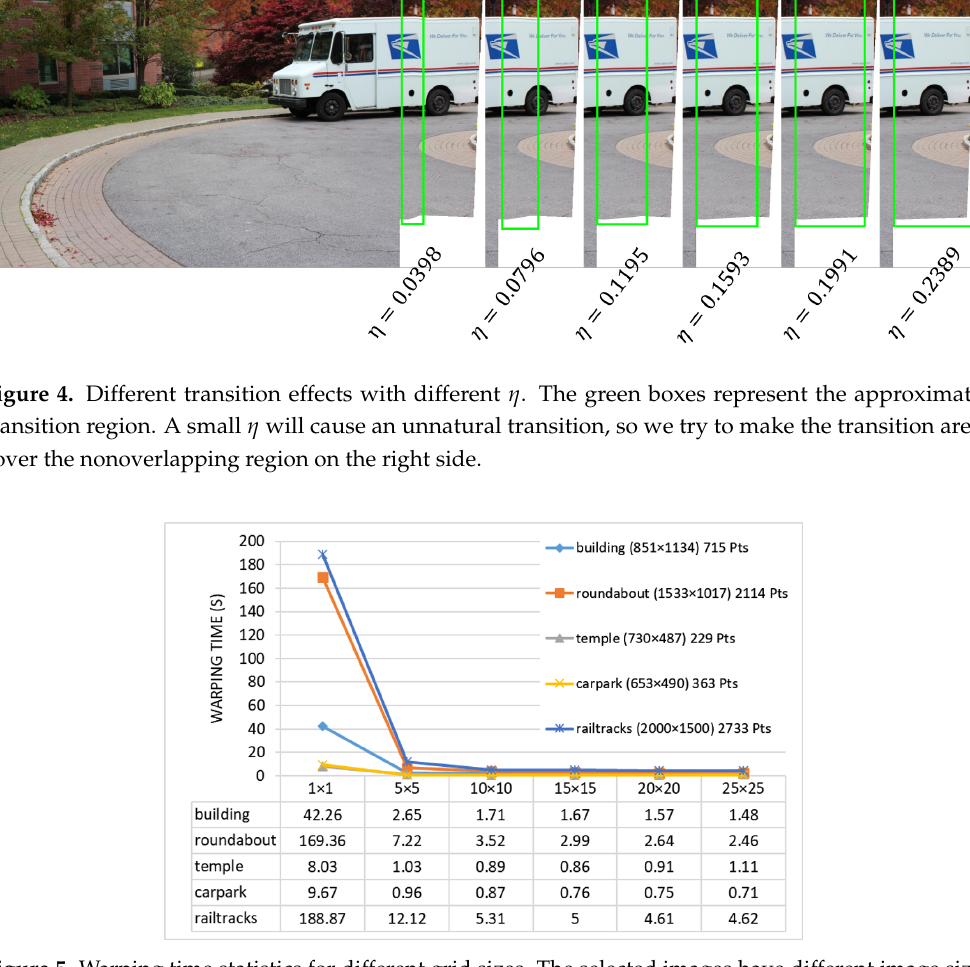
Figure 5. Warping time statistics for different grid sizes. The selected images have different image size and different number of feature points. For each grid size, we count the warping time 10 times and take the average